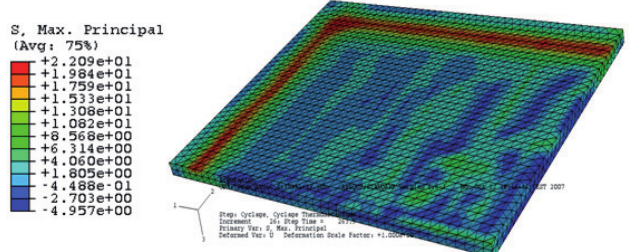
Fig. 15. Maximal principal stress distribution in ceramic sub- strate (MPa).